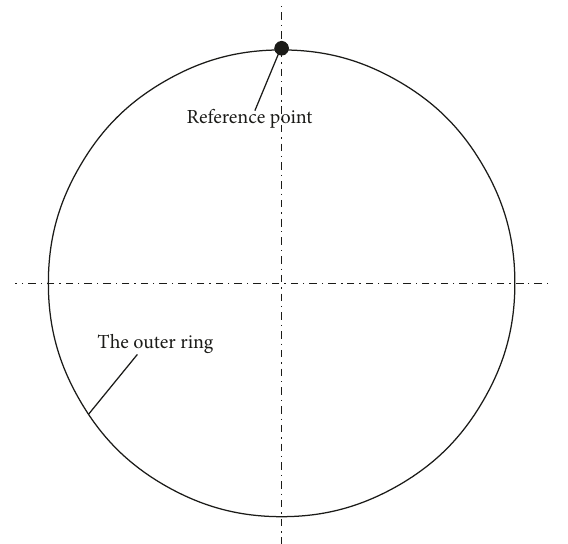
Figure 5: Reference point for the calculation of the outer ring